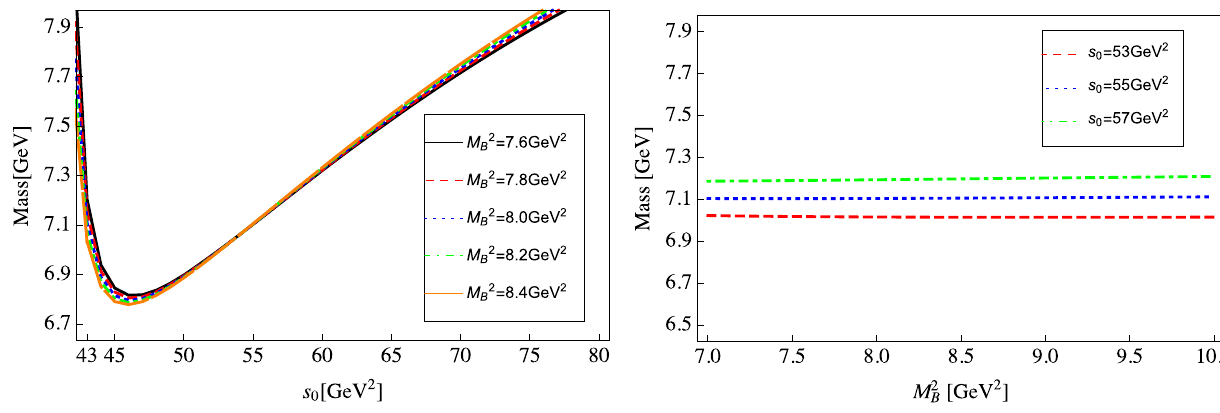
Fig. 4 Variation of m H with s 0 and M 2